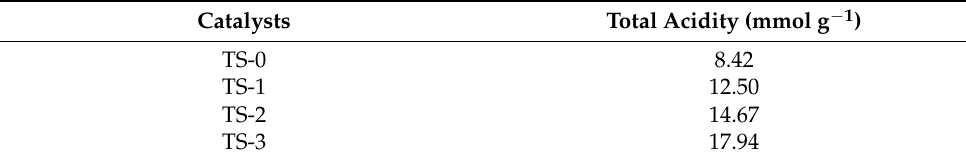
Table 1. Acidity test of catalysts.